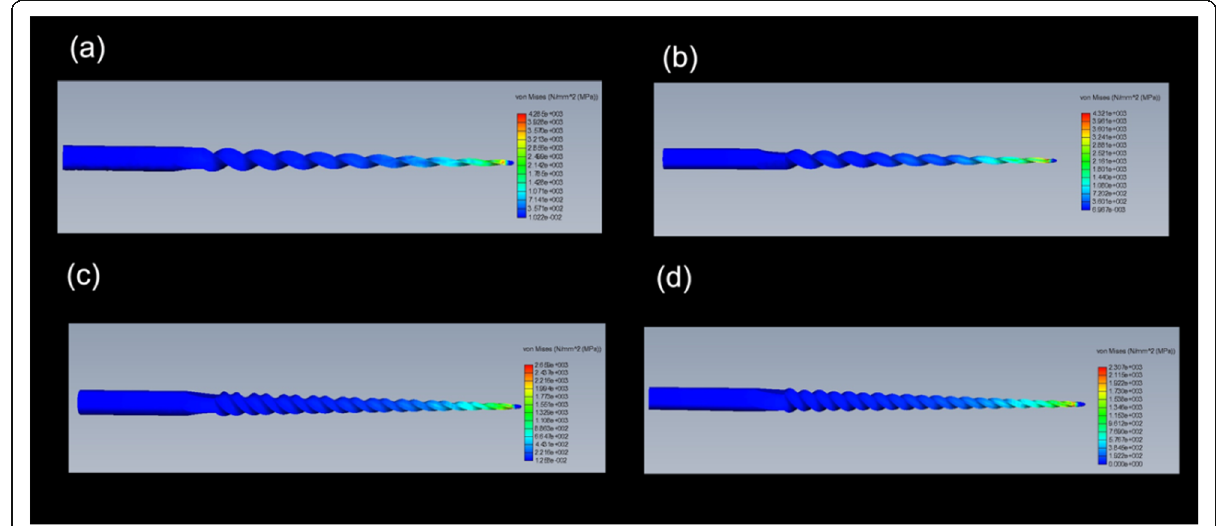
Fig. 4 Stress distribution during torsion of different tested file cross sections. a Triangular cs. b Convex triangle cs. c Rectangular cs. d Parallelogram